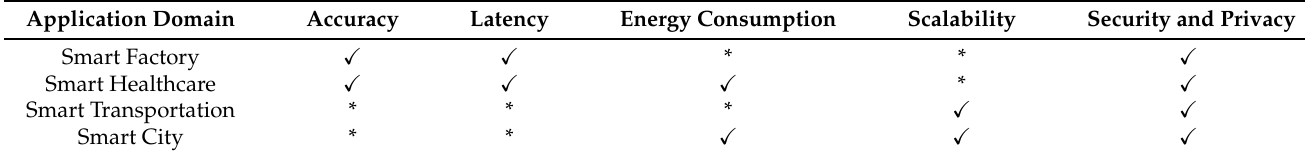
Table 3. Summary of different requirement of IoT systems ( (cid:88) = necessary requirement, * = unnecessary requirement). Application Domain